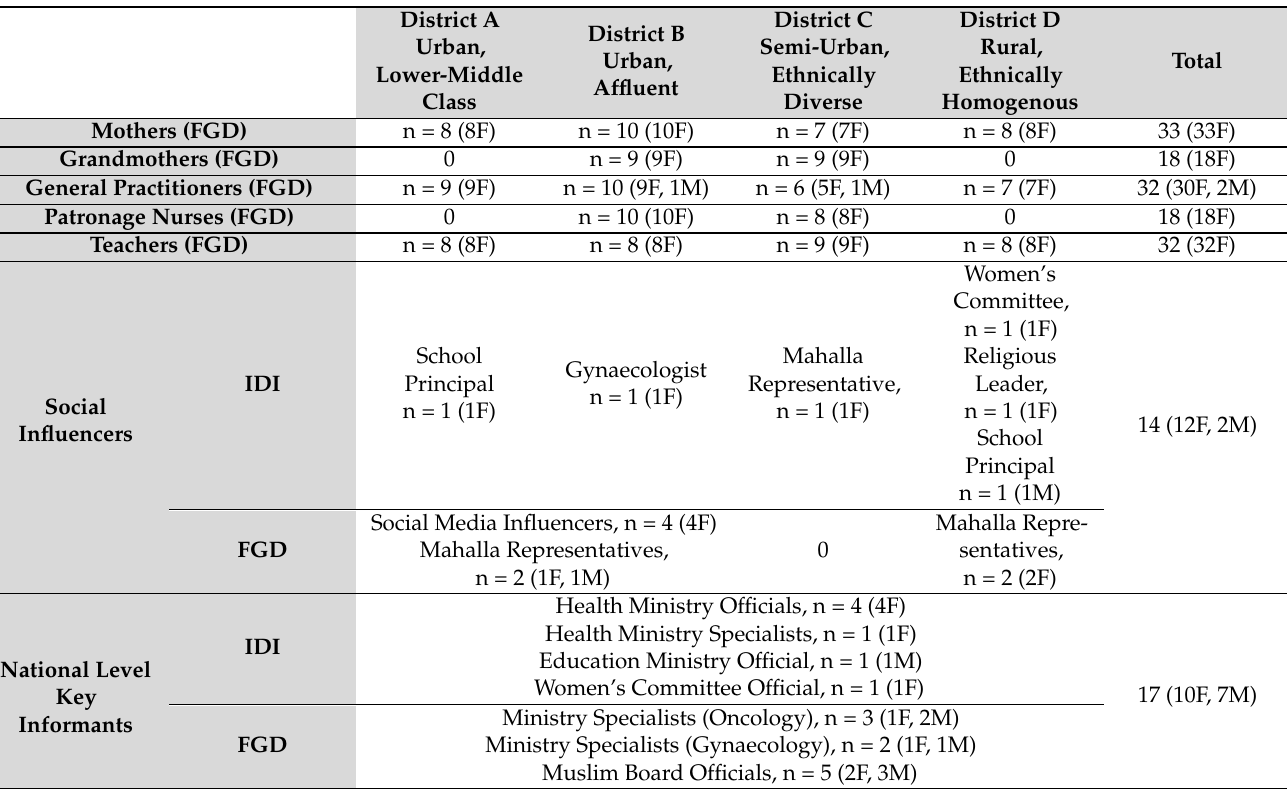
Table 2. Research Participants by Activity across